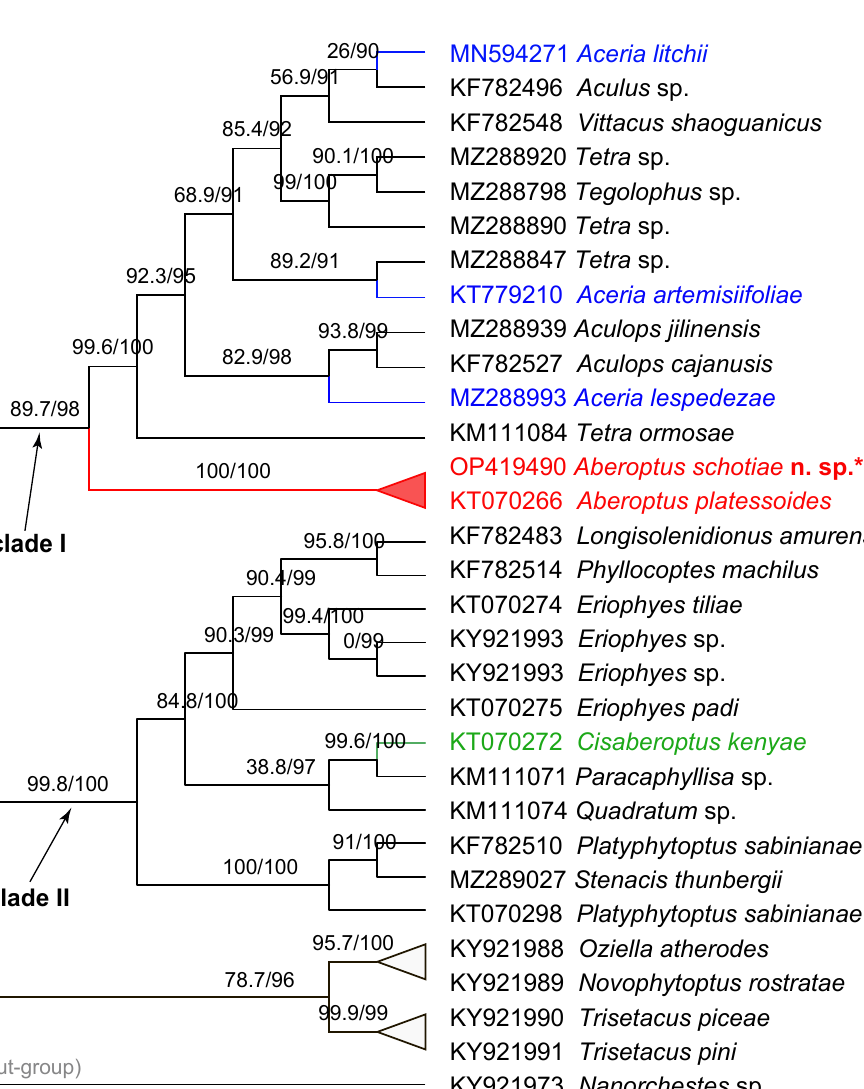
Figure 14. Maximum likelihood tree of Eriophyoidea based on a nucleotide alignment of the D1–D2 regions of 28S gene showing position of the web-spinning mites (colored red and green). Only clades I and II including sequences of Aberoptus and Cisaberoptus are shown; all other clades are omitted (//). Branches are labeled by UF bootstrap support (UFBS), preceded by values of approximate likelihood-ratio test (SH-aLRT). Members of the genus Aceria from clade I are colored blue. Asterisk indicates the new sequence obtained in this